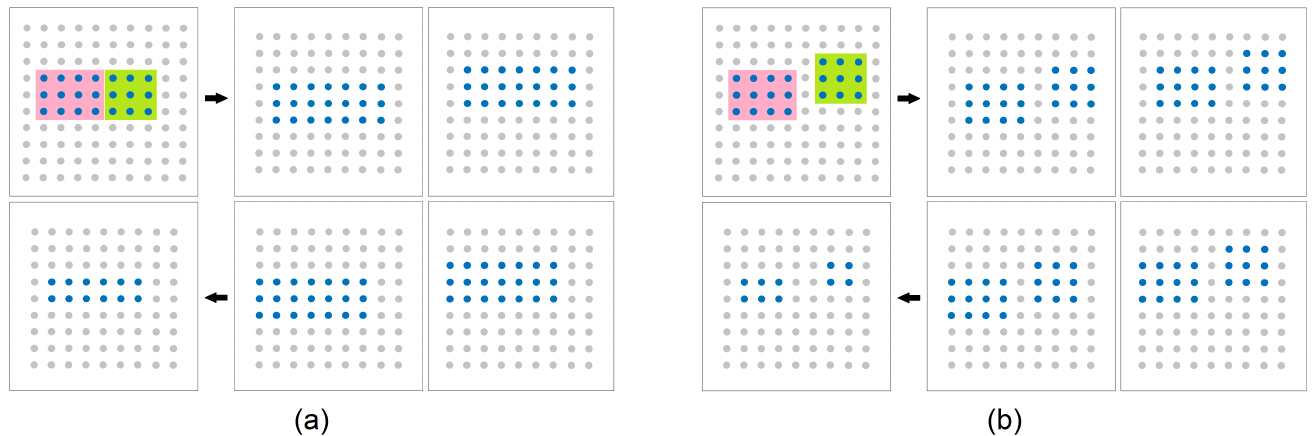
Figure 4. Demonstration of the principle behind maximizing adjacent ones using two sample domains that contain rectangles ( a ) in contact ( b ) separated by zeroes. The sparsity patterns for domain matrices, four submatrices, and elementwise multiplications of the submatrices are shown at the top-left corners, right sides, and bottom-left corners of the subfigures, respectively. The contacting rectangles produce 12 nonzero entities while the separated ones yield 10 nonzero